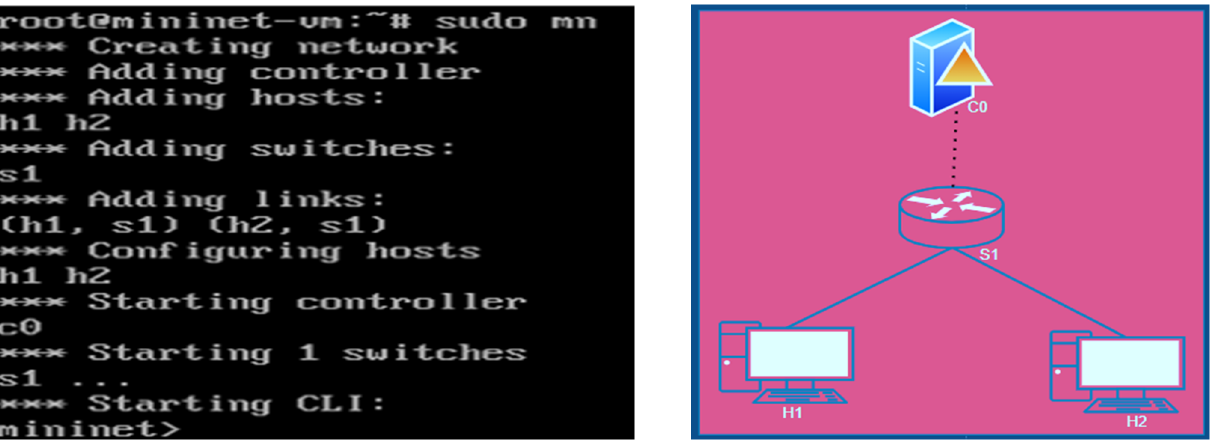
Figure 14. Simple topology Mininet command: sudo mn.